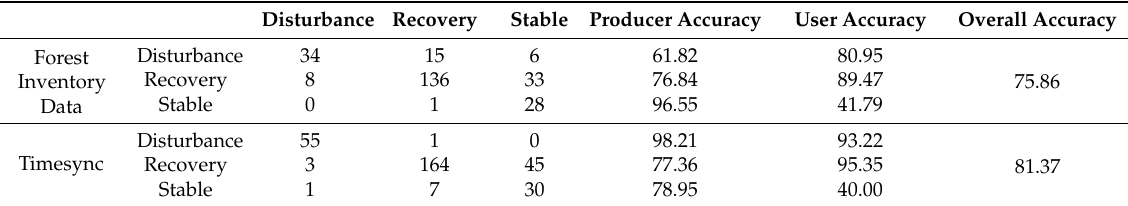
Table 3. Accuracy Assessment Results Based on Two